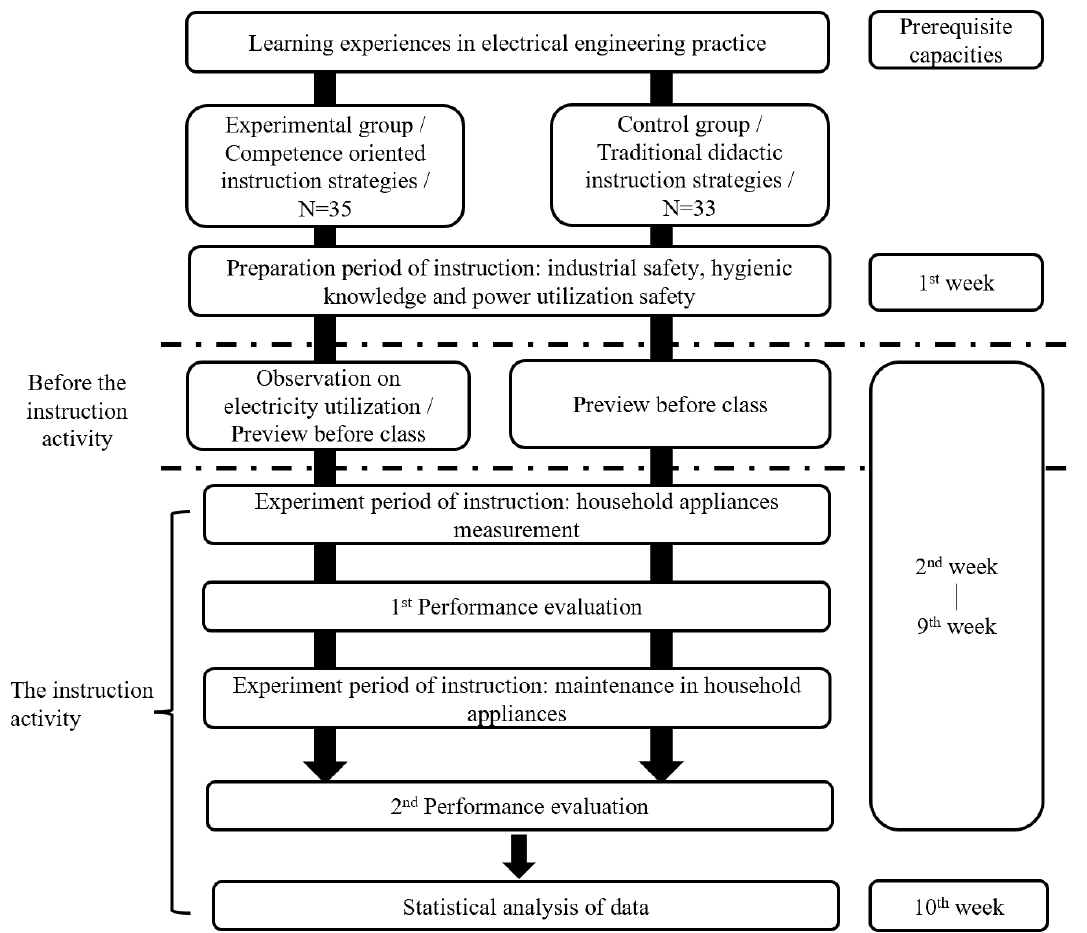
Figure 1. Estimation of path parameters of mediation effect model. Table 1. Instruction experimental design.